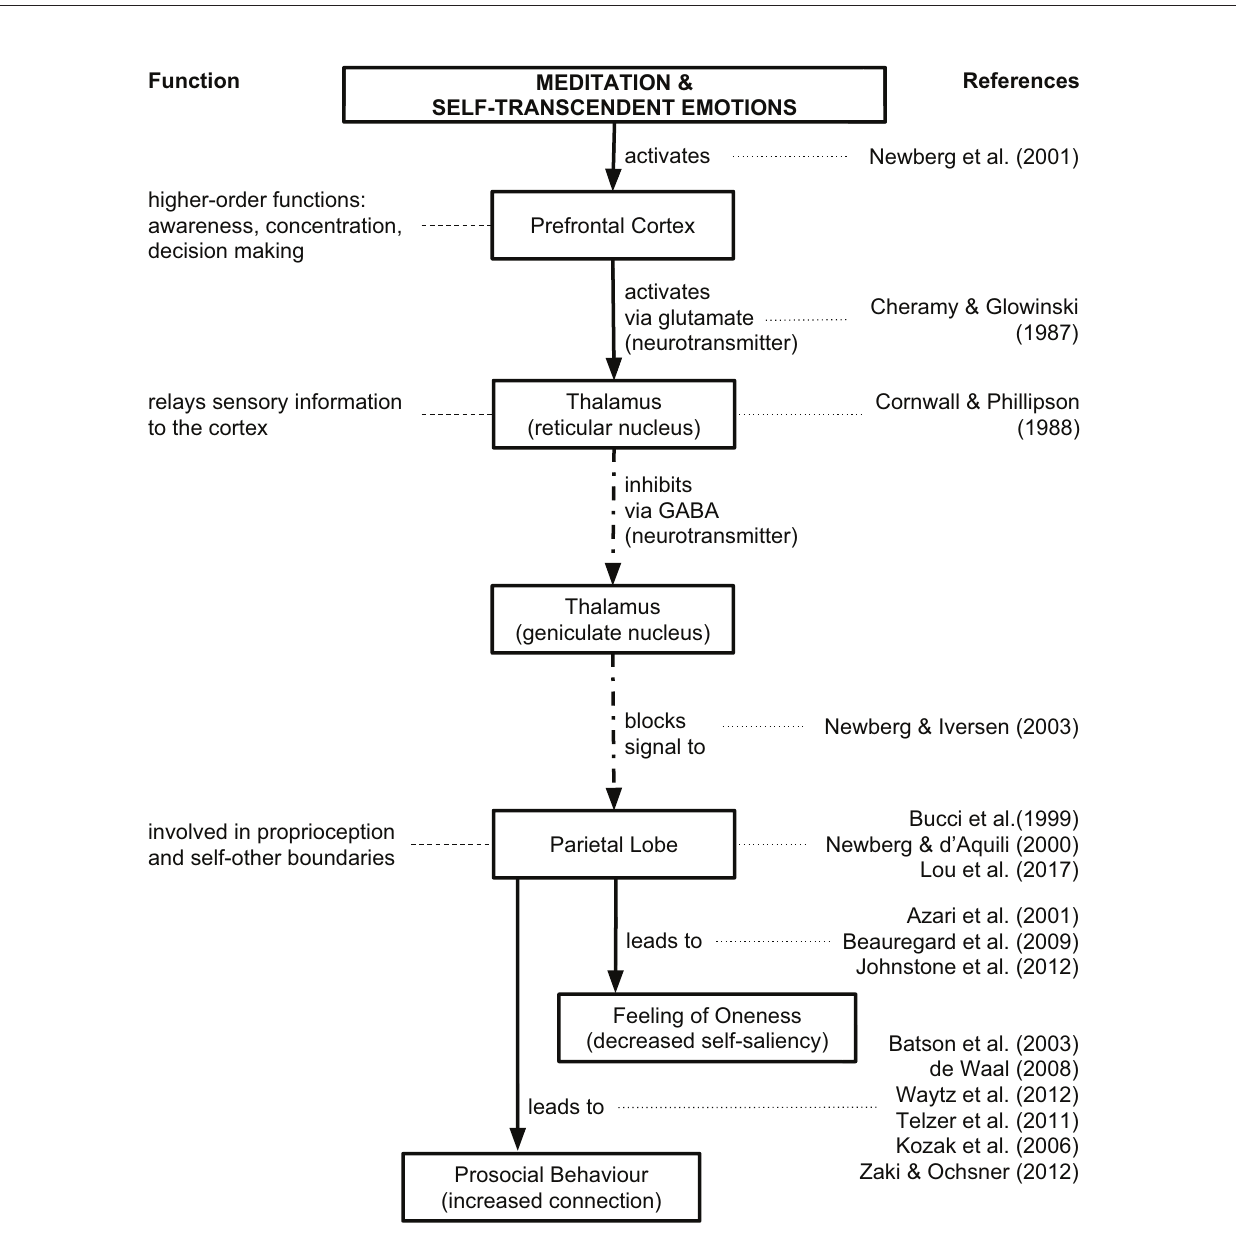
with parasympathetic control of the heart, lungs, and